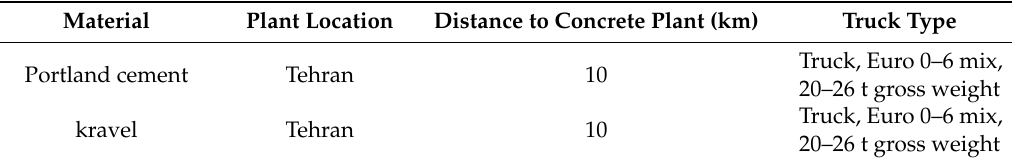
Table 3. Transportation of concrete-BOM.